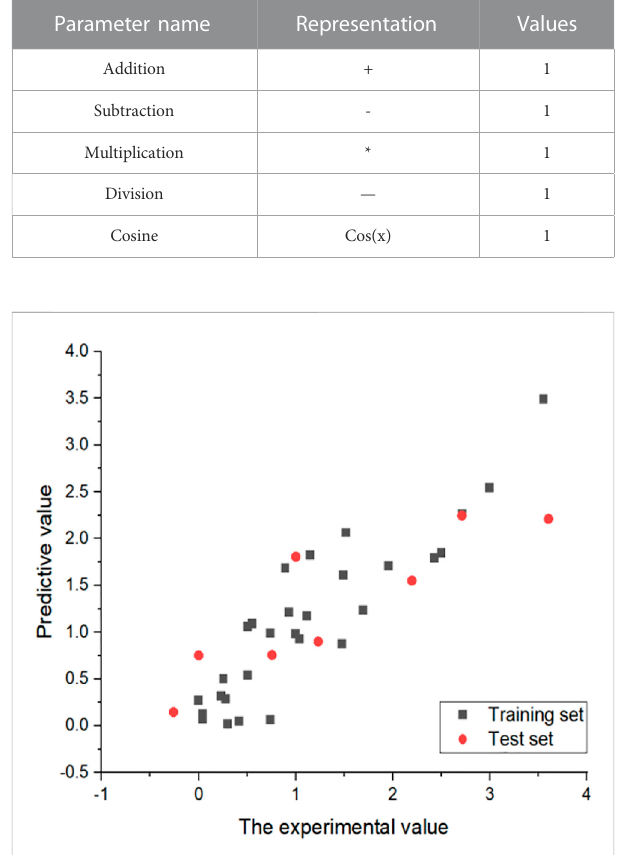
FIGURE 5 Experimentalandpredictedvaluesfornon-linearmodels.AllIC 50 values are converted to log(IC 50 ).